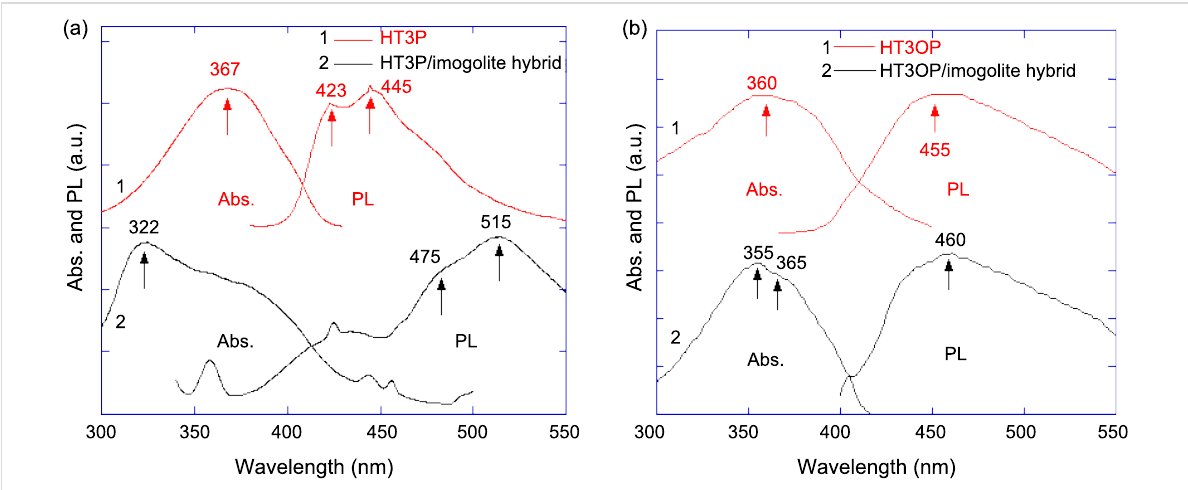
Figure 18: Fluorescence excitation/emission spectra of (a) HT3P, HT3P/imogolite hybrid and (b) HT3OP, HT3OP/imogolite hybrid. The emission wavelengths monitored for the excitation spectra and the excitation wavelengths used for the emission spectra were as follows: (a, 1) λ em = 445 nm, λ ex = 366 nm, (a, 2) λ em = 326 nm, λ ex = 519 nm. (b, 1) λ em = 455 nm, λ ex = 360 nm, (b, 2) λ em = 460 nm, λ ex = 460 nm. Reprinted with permission from W. O. Yah et al., Bull. Chem. Soc. Jpn. 2011, 84, 893–902 [60]. © 2011, The Chemical Society of Japan.